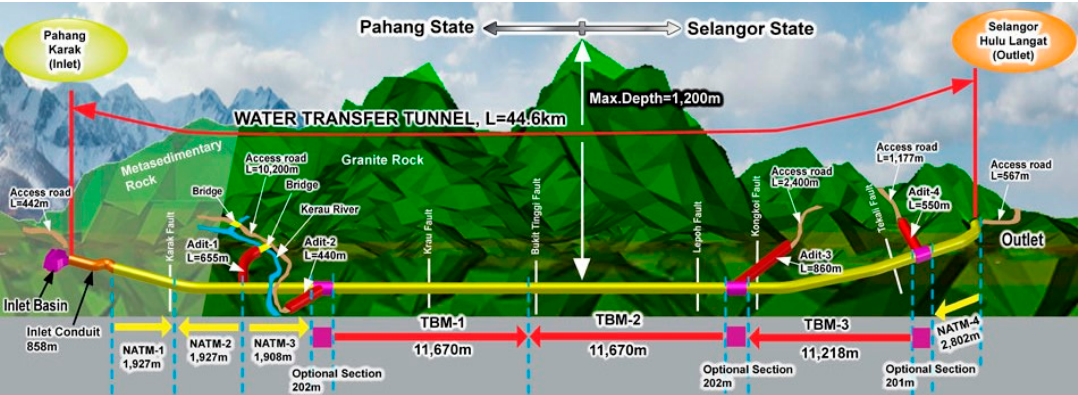
Figure 1. Seven construction parts of the Pahang–Selangor raw water transfer (PSRWT) tunnel with their maximum overburden.